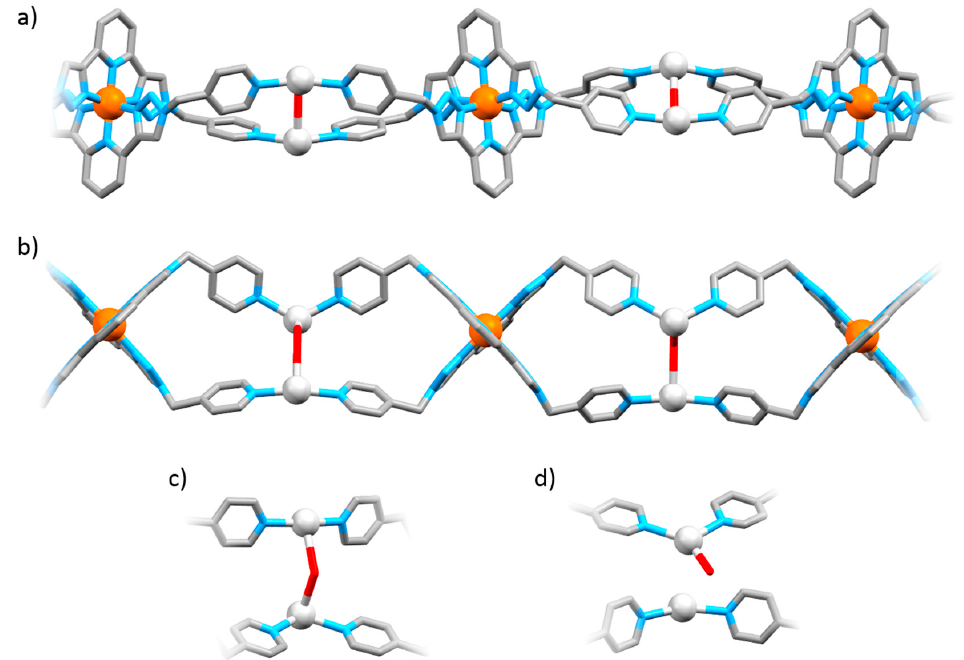
Figure 7. Solid state structure of the heterometallic complex [FeAg 2 ( L ) 2 ](BF 4 ) 4 ·4H 2 O, ( a ) side view ( b ) top view ( c , d ) the disordered [Ag 2 (py) 4 (OH 2 )] + fragments of the coordination polymer. Selected bond lengths (Å): Fe1-N4 = 1.94, Fe1-N5 = 1.93, Fe1-N6 = 1.95, Ag1A-N1A = 2.38, Ag2A-N9A = 2.22, Ag1A-O1 = 2.66, Ag2A-O1 = 2.73. Color scheme: carbon, grey; nitrogen, blue; iron, orange; oxygen, red. Solvent molecules, anions, and hydrogen atoms were omitted for clarity.